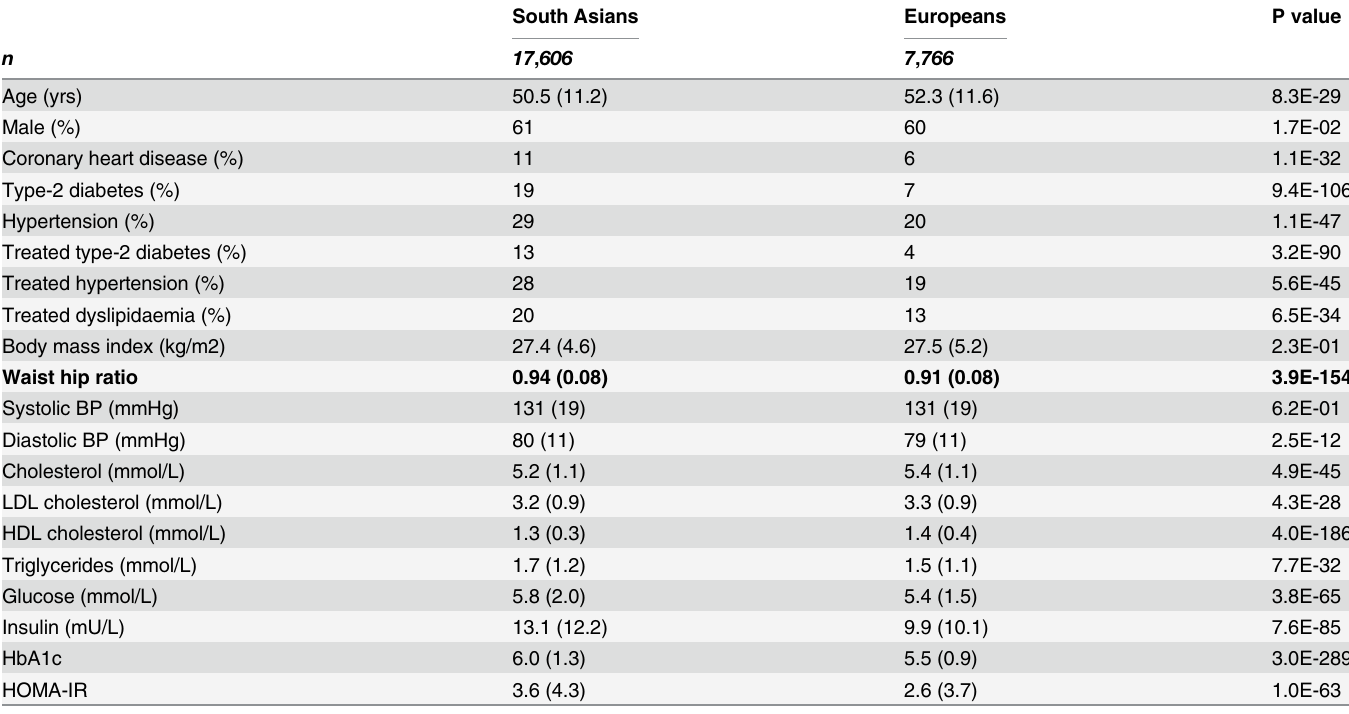
Table 1. Characteristics of participants in the LOLIPOP Study.